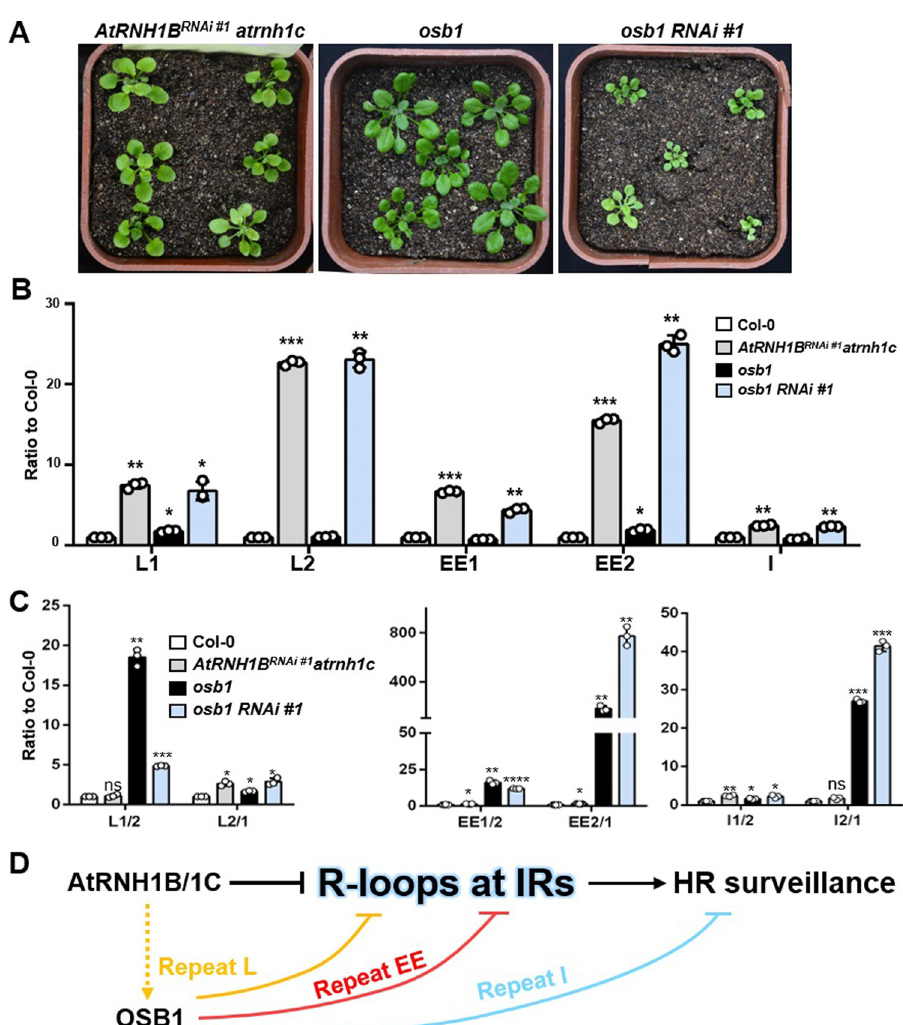
Fig 10. The relationship between AtRNH1B/C and OSB1. (A) Four-week-old AtRNH1B RNAi #1 atrnh1c , osb1 , and osb1 AtRNH1B RNAi #1 atrnh1c plants (shown as osb1RNAi #1 ) . Scale bars, 1 cm. (B) DRIP-qPCR of siliques from Col-0, osb1 , AtRNH1B RNAi #1 atrnh1c , and osb1 RNAi #1. Data are normalized to Col-0 and shown as mean values ± SD; circles show the original data of 3 replicates. One-way ANOVA compared to Col-0 for each primer. � , p < 0.05; �� , p < 0.01. (C) qPCR of the crossover products (as depicted in B) of repeats L, EE, and I from Col-0, osb1 , AtRNH1B RNAi #1 atrnh1c and osb1 RNAi #1. One-way ANOVA compared to Col-0 for each primer. The data underlying this figure can be found in S1 Data. (D) R-loops trigged by AtRNH1B/1C and OSB1 mutation may promote HR of IRs. AtRNH1B/1C could repress mtDNA HR of IRs by modulating R-loops at IRs regions. Another HR surveillance factor, OSB1, controls HR via 3 different mechanisms at different IRs (indicated by 3 different colors). Specifically, OSB1 represses HR of repeat I independent R-loop and HR of repeat EE and L, which is partially dependent on inhibiting R-loop formation. In addition, AtRNH1B/1C has an epistatic effect to OSB1 at repeat L but a parallel effect to OSB1 at repeat EE. ANOVA, analysis of variance; DRIP, DNA:RNA hybrid immunoprecipitation; HR, homologous recombination; IR, intermediate- sized repeat; mtDNA, mitochondrial DNA; OSB1, ORGANELLAR SINGLE-STRANDED DNA BINDING PROTEIN1; qPCR, quantitative PCR; RNAi, RNA interference; SD, standard deviation.